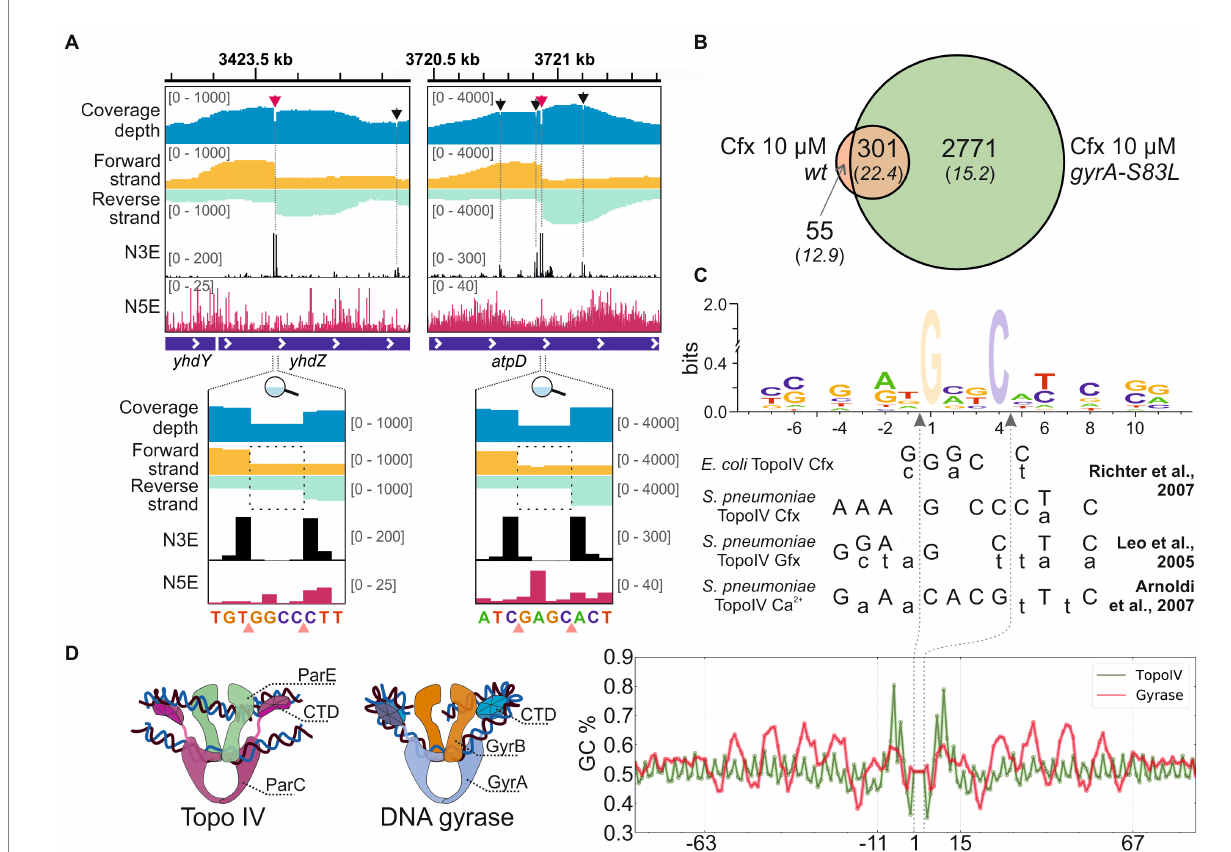
FIGURE 1 Detection of Topo IV TCSs with Topo-Seq. (A) Representative TCSs and cleavage patterns. The total sequencing coverage depth is shown in blue at the top. Coverage depths for forward and reverse strands are shown in gold and turquoise, respectively. Profiles of the number of 5 ′ - (N5E) and 3 ′ -ends (N3E) are shown in black and red, correspondingly. Tracks depths are shown in brackets. TCSs are shown with arrows and dashed lines. Primary and satellite TCSs (see text) are shown with red and black arrows, correspondingly. Zoom-in views of primary cleavage sites are shown below. Cleavage sites are shown with pink triangles. Dashed rectangles mark the gaps between coverage depths on forward and reverse strands. The data were visualized in IGV (Thorvaldsdóttir et al., 2013). (B) A Venn diagram representing an overlap between TCSs sets identified for wt and gyrA-S83L strains. (C) Logo representation of Topo IV cleavage motif determined with Topo-Seq. Cfx-biased positions at positions +1 and + 4 are translucent. Below the logo, cleavage consensus sequences identified previously for E. coli and S. pneumonia Topo IV in vitro are shown (Leo et al., 2005; Richter et al., 2007; Arnoldi et al., 2013). Preferred bases are shown in capital letters and non-preferred bases are shown in lowercase letters. Gfx—gemifloxacin. Vertical dashed arrows indicate positions of cleavage sites. (D) The Topo IV motif (green) and the DNA gyrase ‘combined’ motif (red) are shown as plots of GC content (right). Cartoon representations of Topo IV and DNA gyrase complexes with G- and T-segment DNAs are shown on the